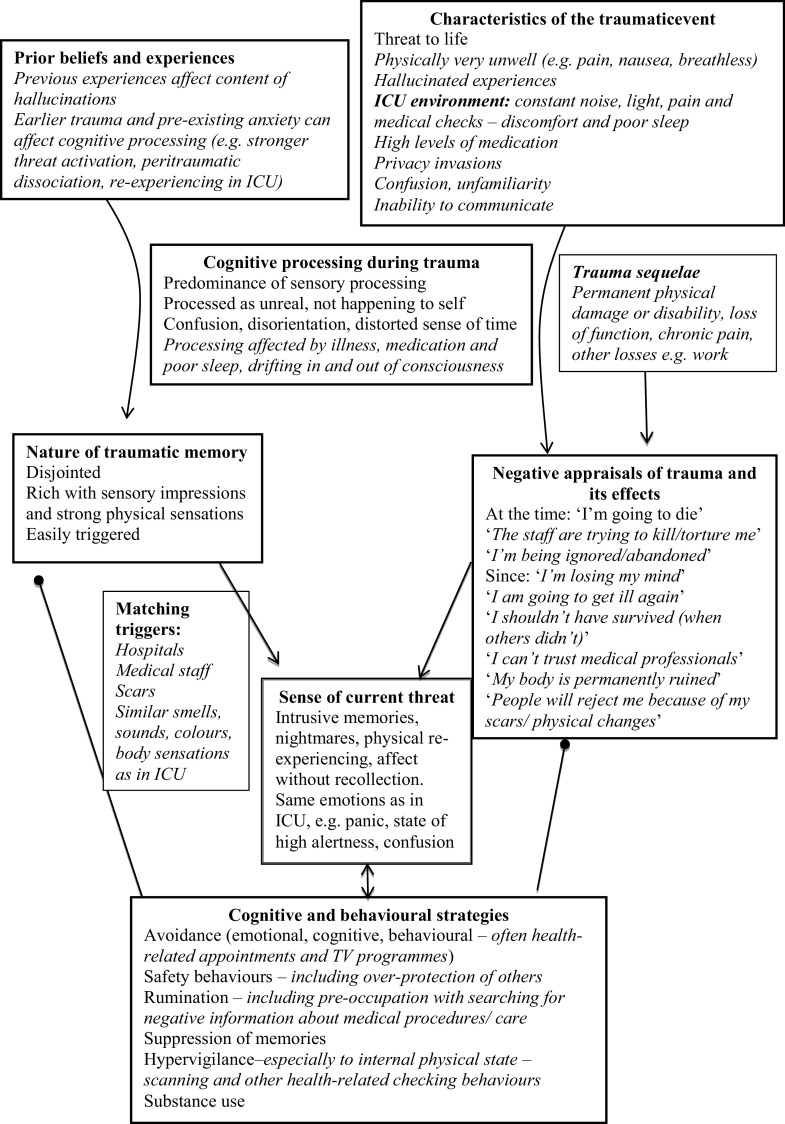
Ehlers and Clark’s (2000) cognitive model of PTSD, applied to post-ICU PTSD.